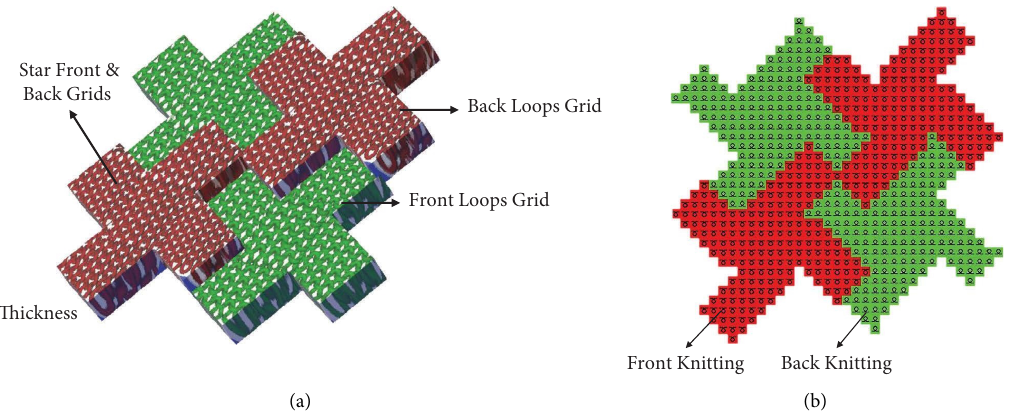
Figure 3: (a) 3D diagram of star structure and (b) knitting notation of star